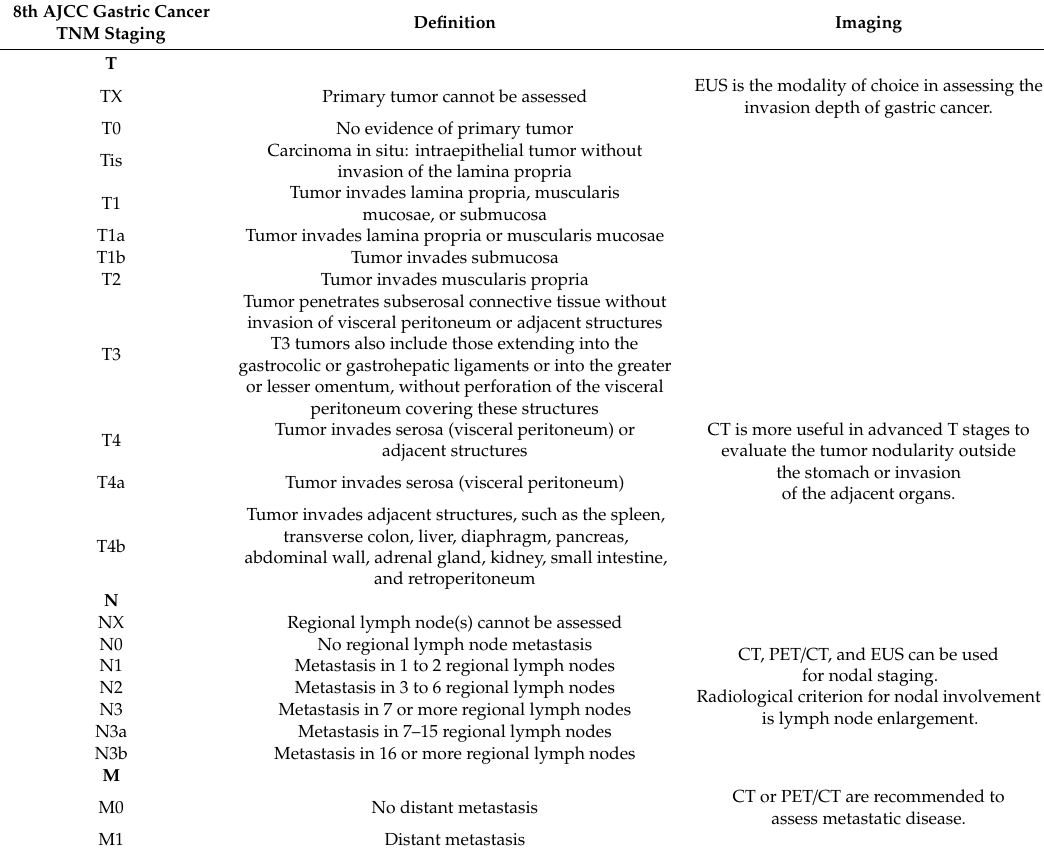
Table 1. Eighth edition American Joint Committee on Cancer (AJCC) Tumor Nodes Metastasis (TNM) staging for gastric neoplasms with suggested imaging for staging (adapted from Amin et al. [12] and from the National Comprehensive Cancer Network (NCCN) Guidelines